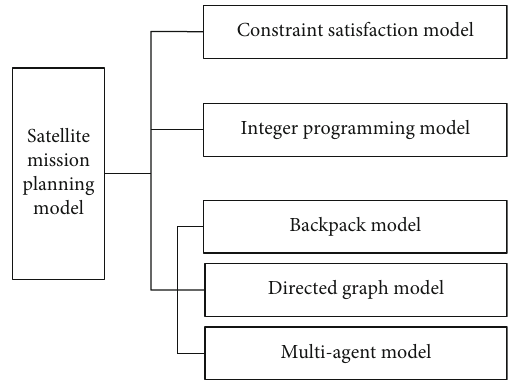
Figure 7: Classi fi cation of task planning